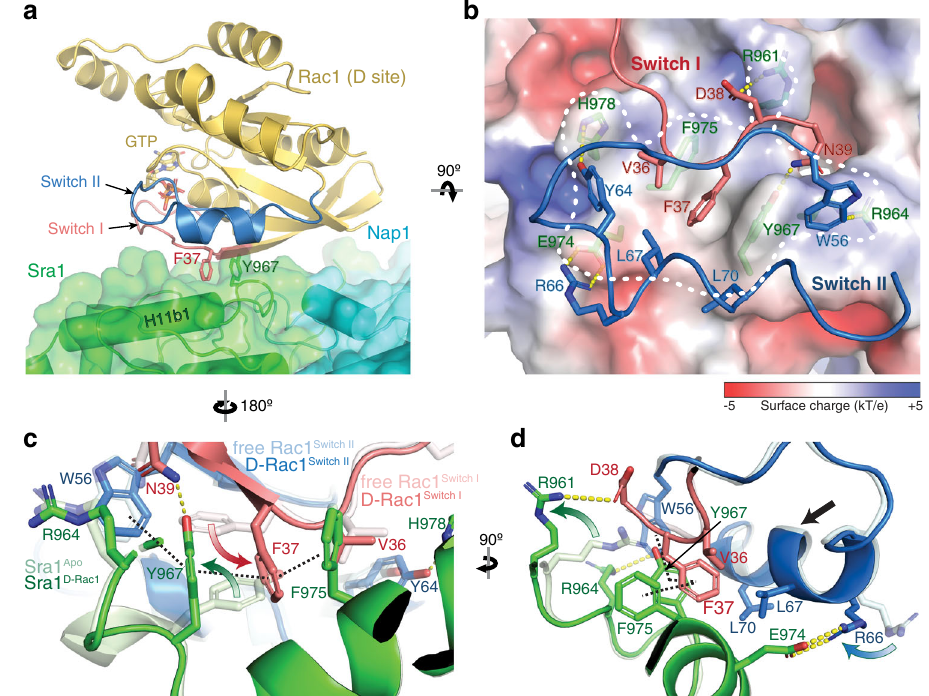
Fig. 2 | Interactions mediating Rac1 binding to the D site. a Side view of the overall structure of Rac1 (cartoon, gold) binding to the D site (semitransparent surface,green).F37andY967sidechainsareshownasreferencepoints. b Topview and semitransparent surface charge representation of the D site (calculated using APBS in Pymol 45 ), showing key interactions between Sra1 and Rac1. Yellow dotted lines indicate polar interactions. White dashed line indicates binding surface